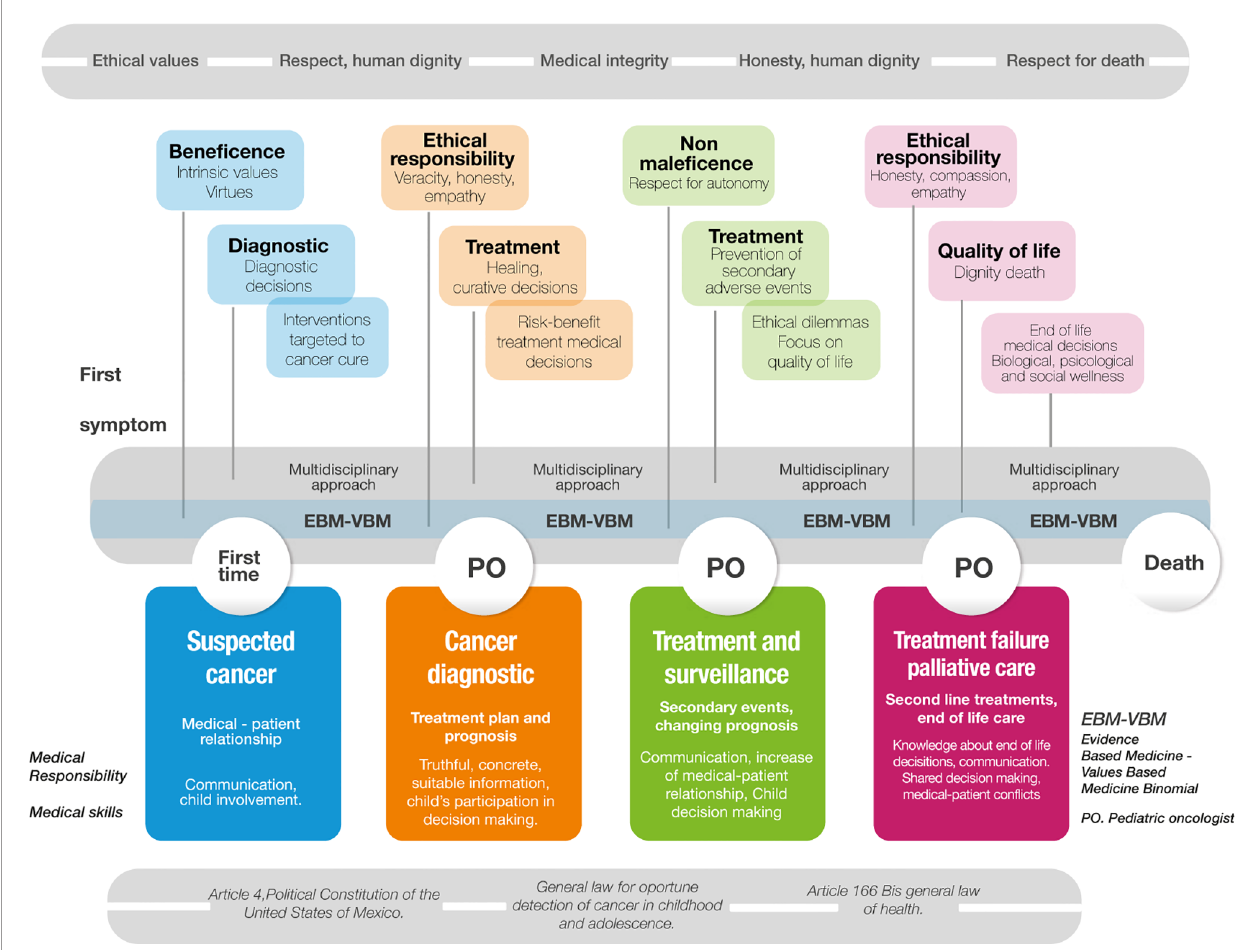
FIGURE 7 | Authors model of multidimensional care for children with cancer based on binomial evidence-based medicine-value-based